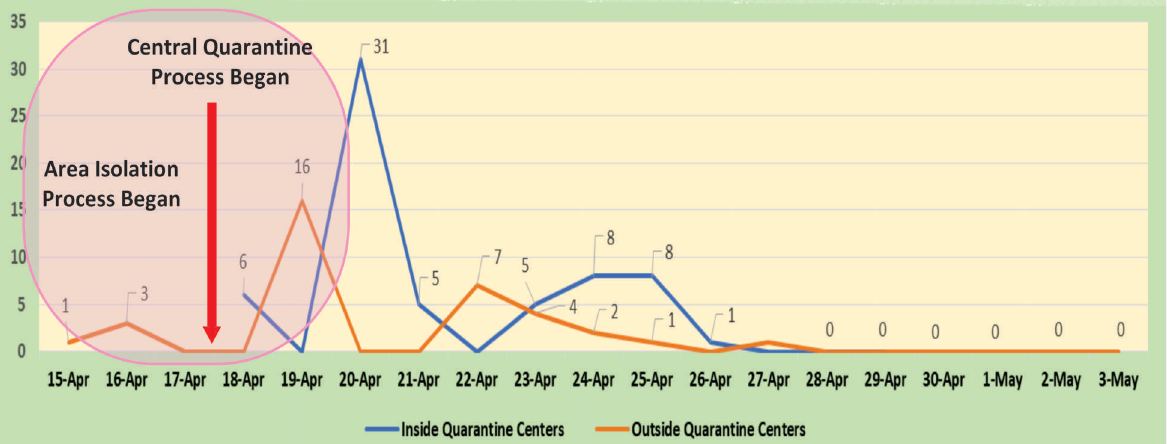
Figure 6: Controlling of the cluster in Colombo